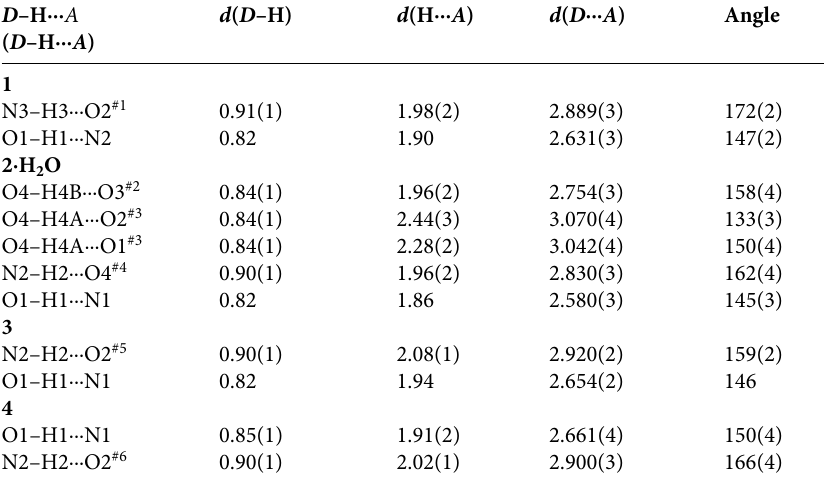
Table 2. Hydrogen bond distances (Å) and bond angles (°) for the compounds.